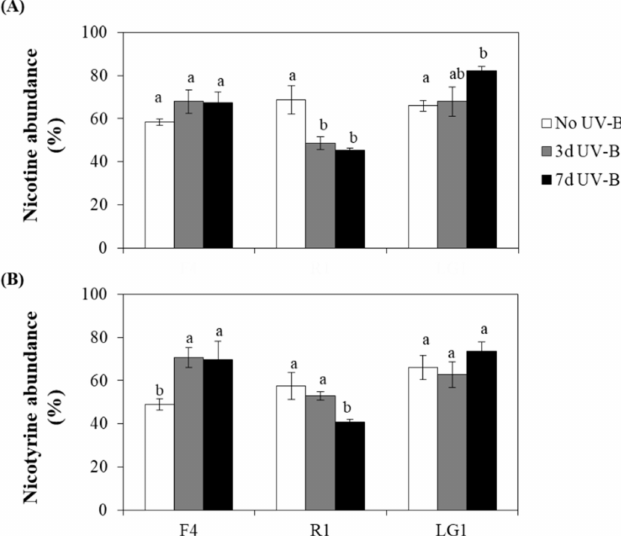
Figure 3. Effect of UV-B on the microalgal removal capacity of main toxic pollutants in cigarette butt (CB) wastewater. The relative abundance of ( A ) nicotine and ( B ) nicotyrine was determined in the wastewater after microalgal-based remediation by 7-day cultures. The abundance is expressed in % (kcounts/kcounts) and was obtained by its comparison with the abundance in the respective untreated wastewater (without microalgal cells), which represented 100%. Microalgal strains (F4, R1 and LG1) were exposed to wastewater and sequential (3 d UV-B) or parallel (7 d UV-B) UV-B treatments. The UV-B exposure level was set at 1.7 W m − 2 and supplemented with 70 µ mol m − 1 s − 1 photosynthetically active radiation (PAR) for 20 min each day. The control microalgal group only received PAR (No UV-B). For more details, see Section 4. Different letters represent significant differences ( p < 0.05) between UV-B treatments within the same strain. Data are expressed as means of 4 different replicates ± standard error